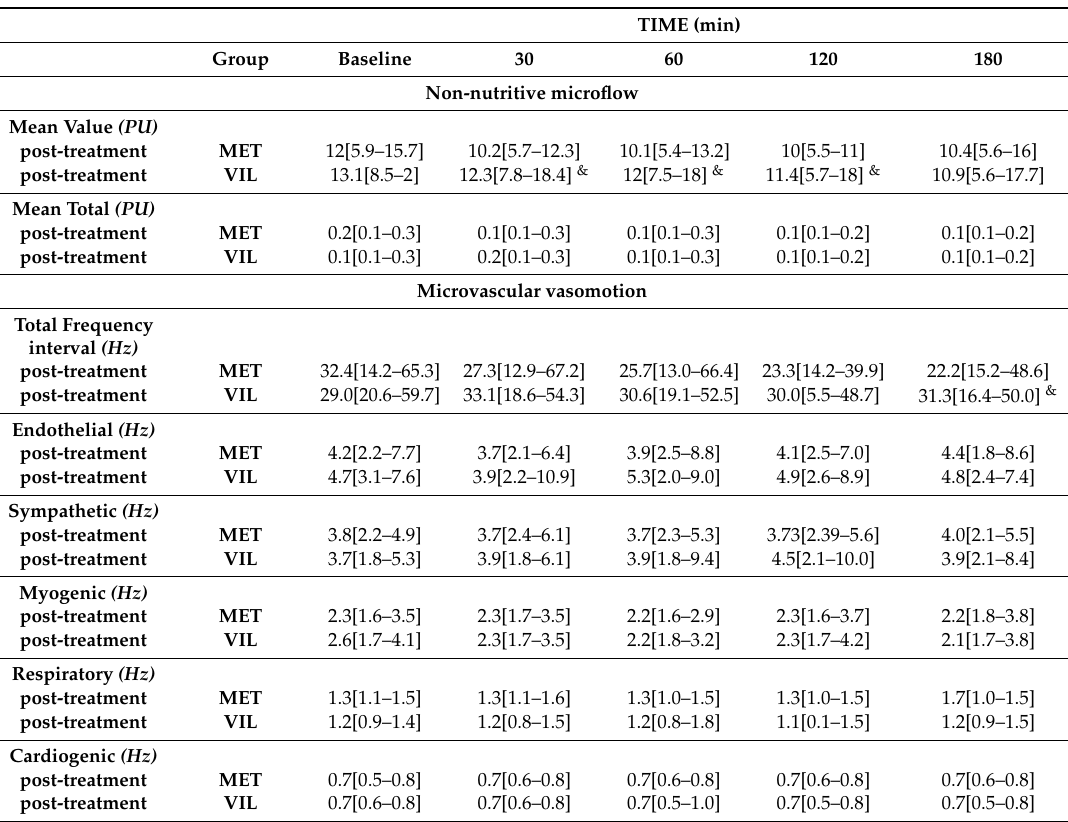
Table 4. E ff ects of vildagliptin and metformin on postprandial non-nutritive microvascular reactivity and